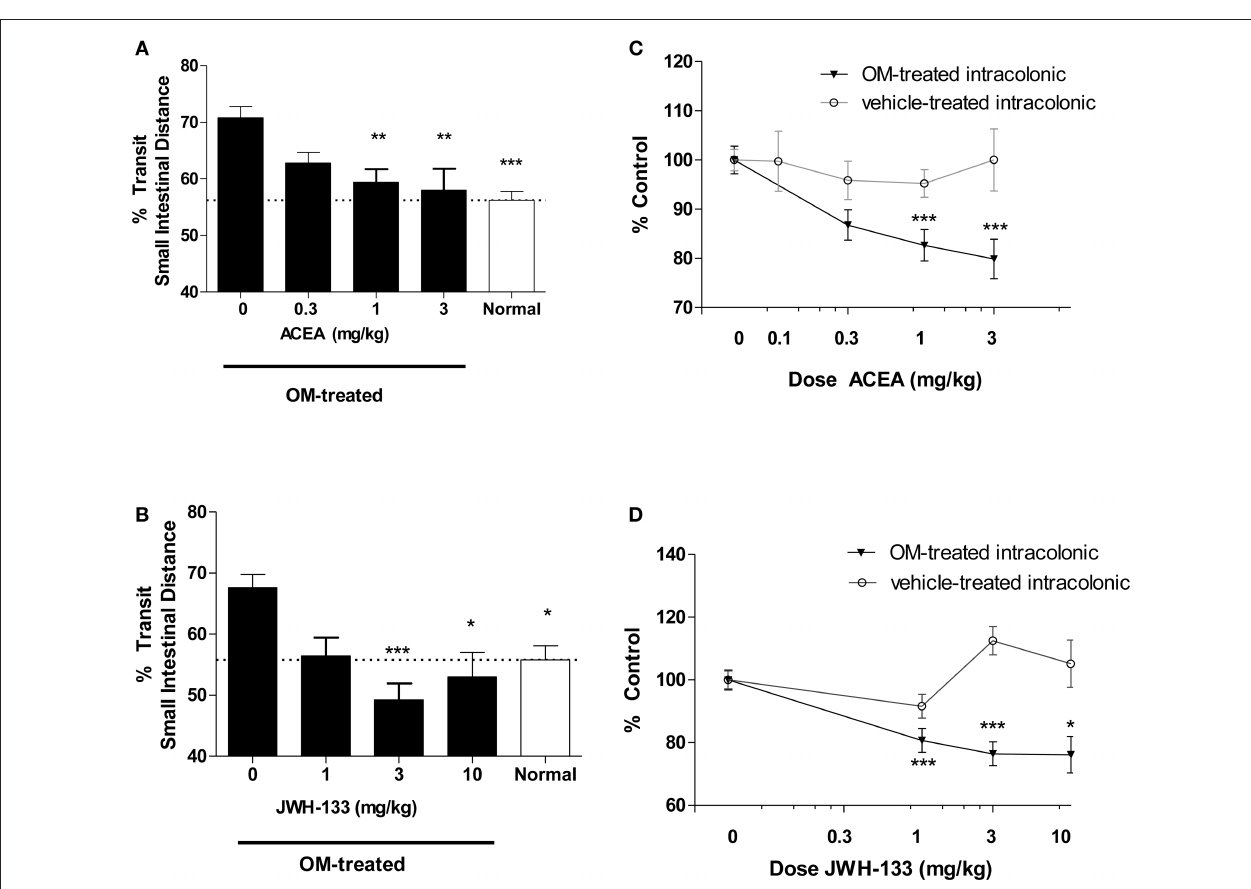
Figure 3 | effects on small intestinal transit of a range of doses of CB1r (A,C) and CB2R agonists (B,D) in mice 28 days after intracolonic 0.5% OM, vehicle (30% ethanol) and normal (untreated) age-matched mice. In (A) and (B) the % small intestinal distance traveled by carmine red is illustrated, with statistical comparisons to intracolonic vehicle-treated mice (i.e., first column in A , B ). Effective